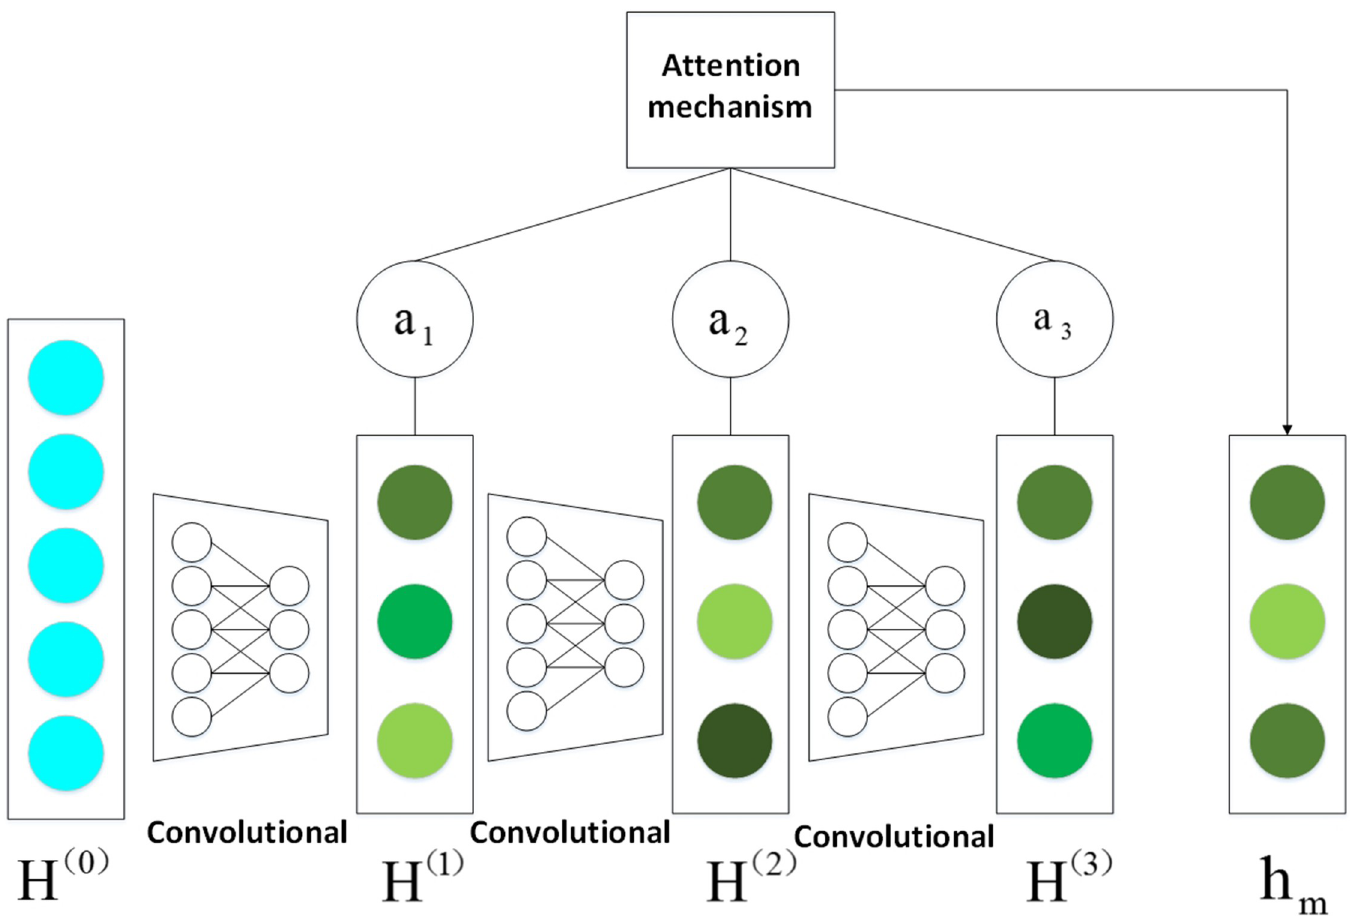
Fig 3. The overview of feature processing in encoder.